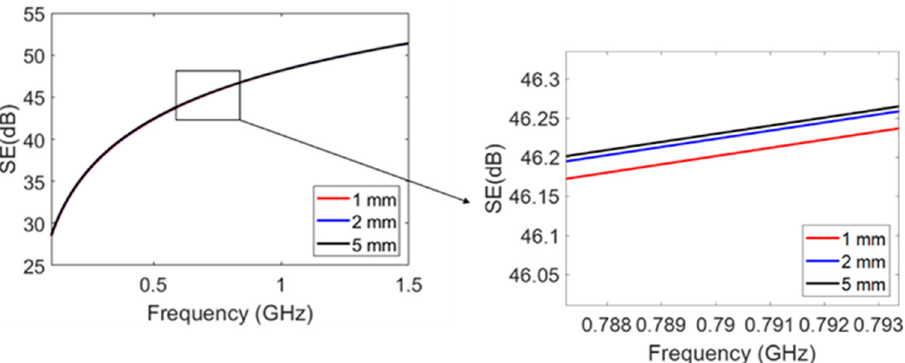
Figure 13. Comparison of different thicknesses of coating layers on the EMI SE of PPA with an aluminum bronze coating (simulation using ANSYS HFSS).